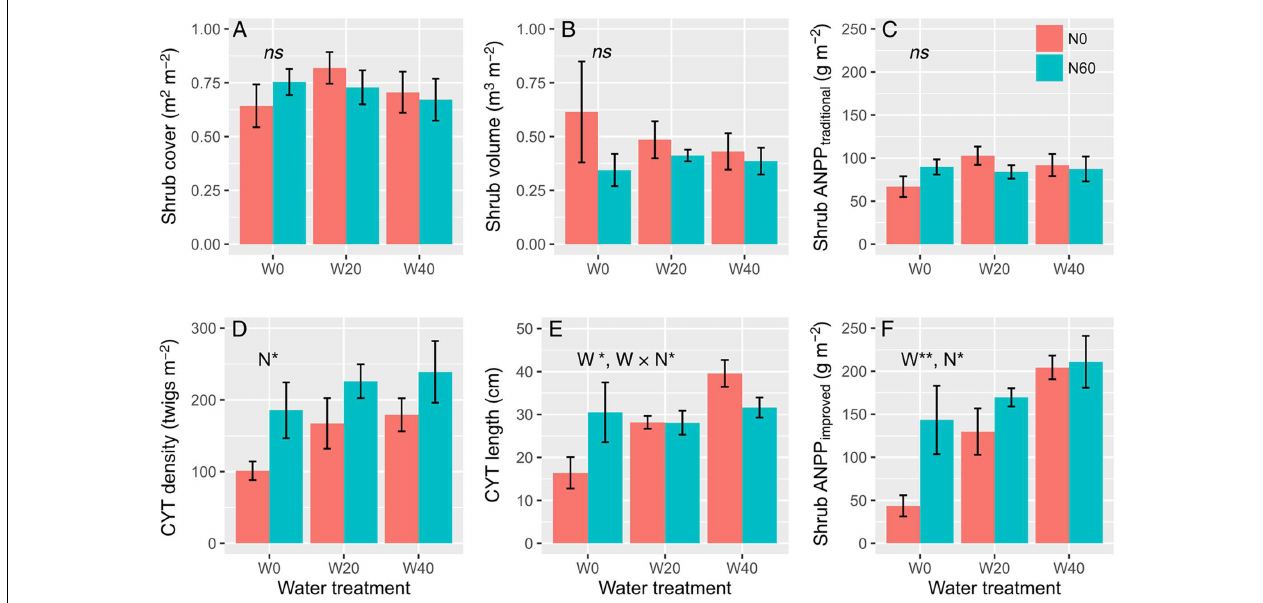
FIGURE 1 | Effects of water and nitrogen addition on shrub cover (A) , shrub volume (B) , shrub ANPP estimated from the traditional (C) and improved methods (F) , and twig density (D) and length (E) of A. ordosica ( ∗ P < 0.05, ∗∗ P < 0.01; ns, not significant).